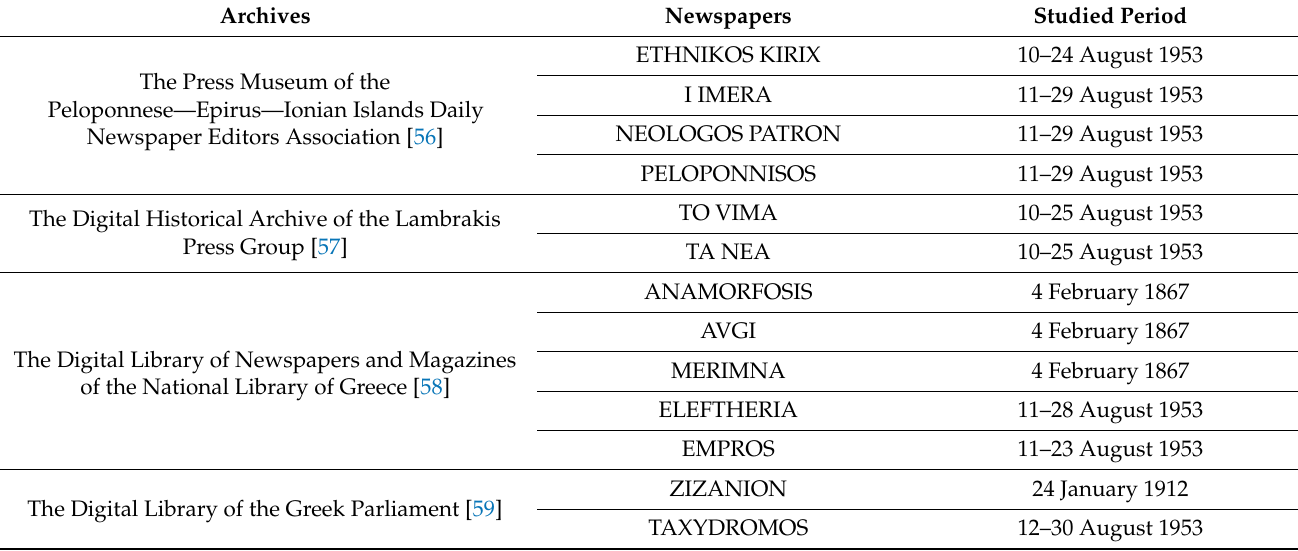
Table 1. Contemporary sources comprising newspapers and magazines of local and national cir- culation used in this study for revisiting landslides induced by historical and recent earthquakes generated in